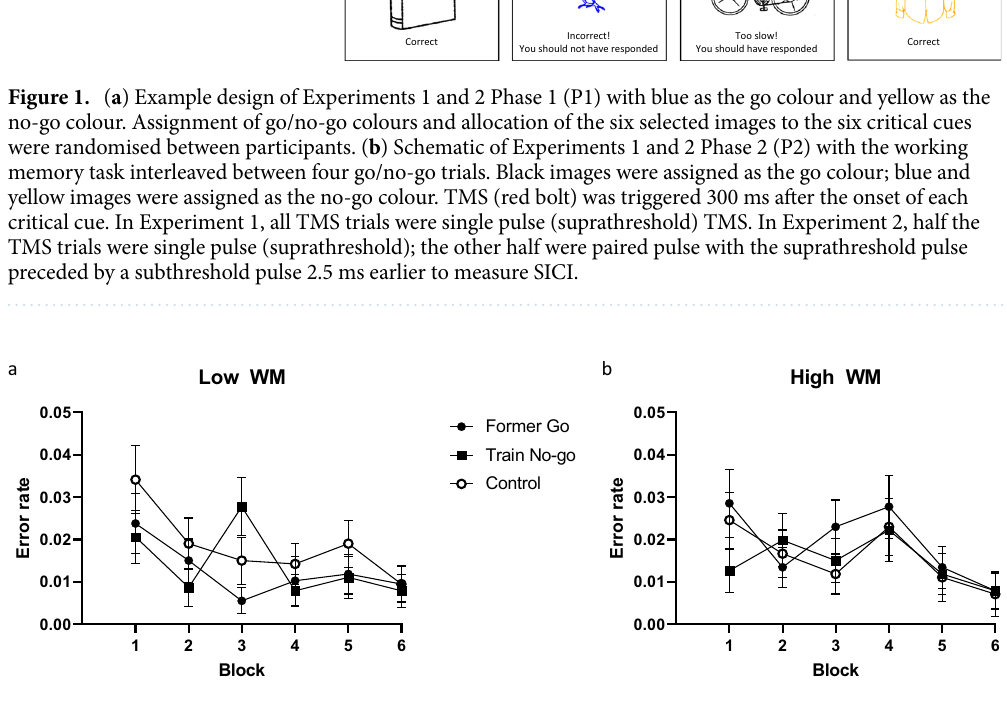
Figure 2. Commission errors during Phase 2 pooled from Experiments 1 and 2. Error rates for cue type by block separated for low ( a ) and high ( b ) working memory load. Error bars represent within-participant standard errors. Note that Experiment 2 Phase 2 was longer than Experiment 1 Phase 2 due to the addition of paired pulse TMS trials. The Phase 2 data were split into 6 equal blocks in each experiment for graphical representation and statistical